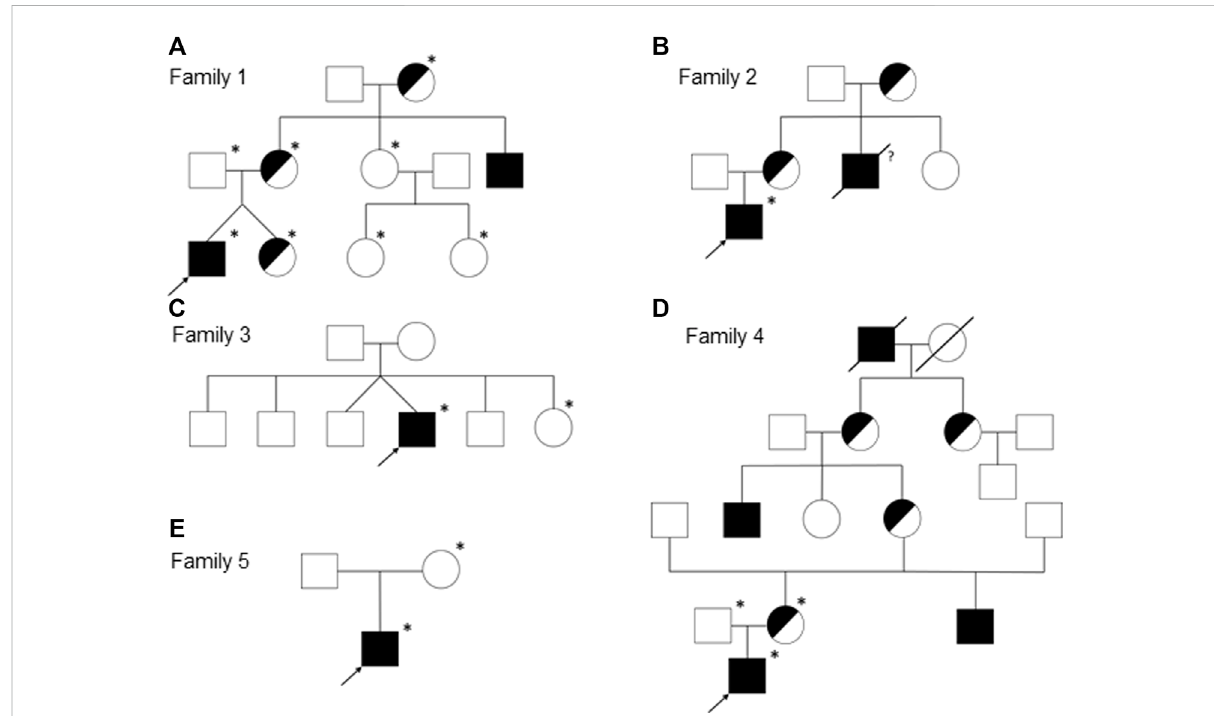
FIGURE 1 Pedigrees of the families 1 (A) , 2 (B) , 3 (C) , 4 (D) , and 5 (E) . Females are represented by circles, males by squares, presumed (heterozygous) carriers by half-shaded symbols, and subjects with fully expressed phenotypes by fi lled symbols. Arrows indicate the index patients of the respective families and asterisks the genotyped individuals. A slash through the symbol designates deceased persons and the question mark indicates an uncertain affection